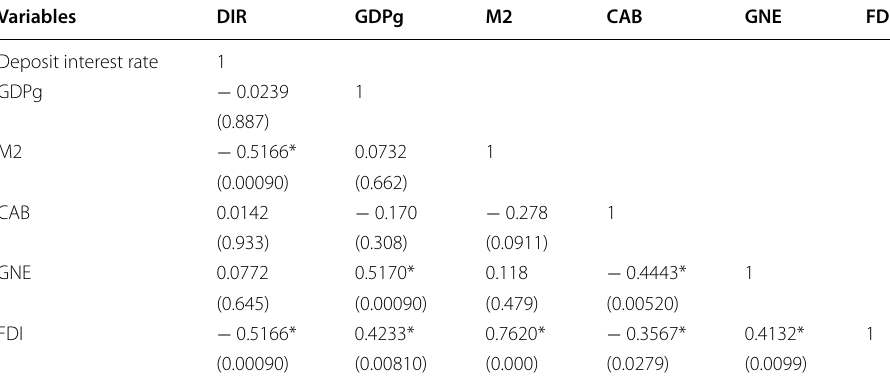
Table 1 Correlation matrix. Source: Author’s computation from World Development Indicators database for